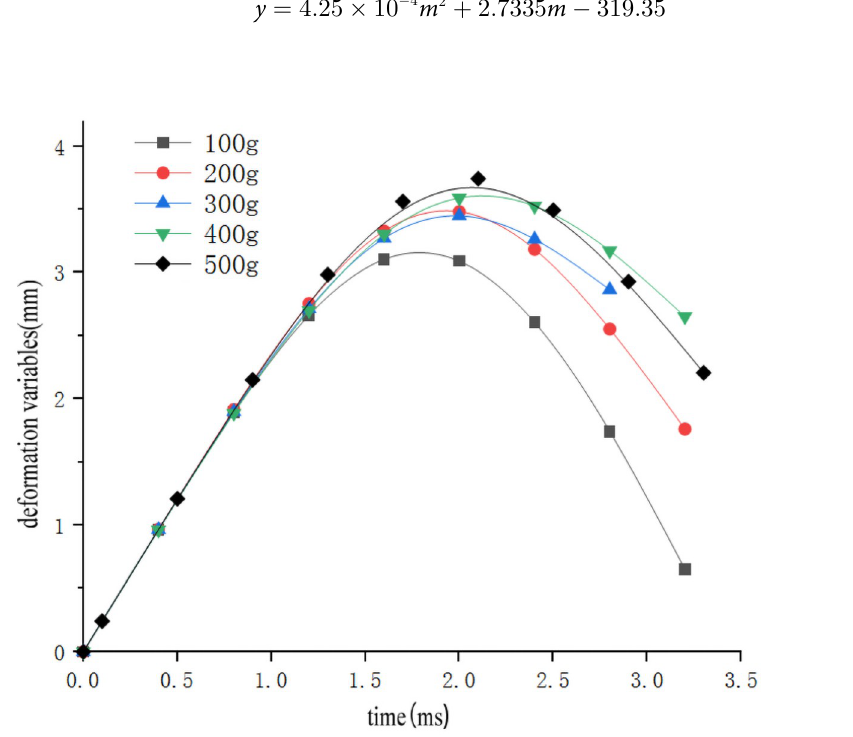
Fig 17. Impact deformation-time relationship of different sizes of sweet potato